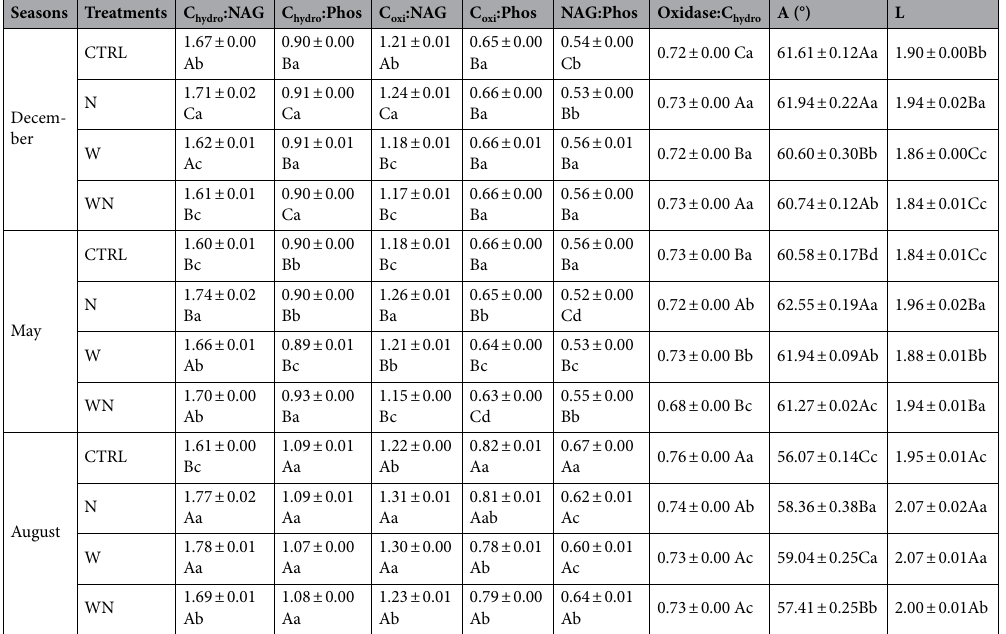
Table 1. Enzymatic ratios and vector analysis in long-term warming (W), nitrogen fertilization (N) and combined treatments (WN). C hydro is the sum of αGlu , βGlu , CBH and βX ; C oxi is the sum of PPO and PER . A is vector angle, L is the vector length. ln is log transformation. Small and capital letters show significant differences between treatments in the sampling time, and between sampling times in the same treatment, at 95% confidence level (n = 3, p < 0.05).